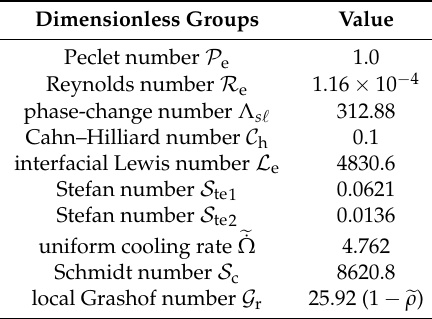
Table 2. Dimensionless groups with values based on parameters listed in Table